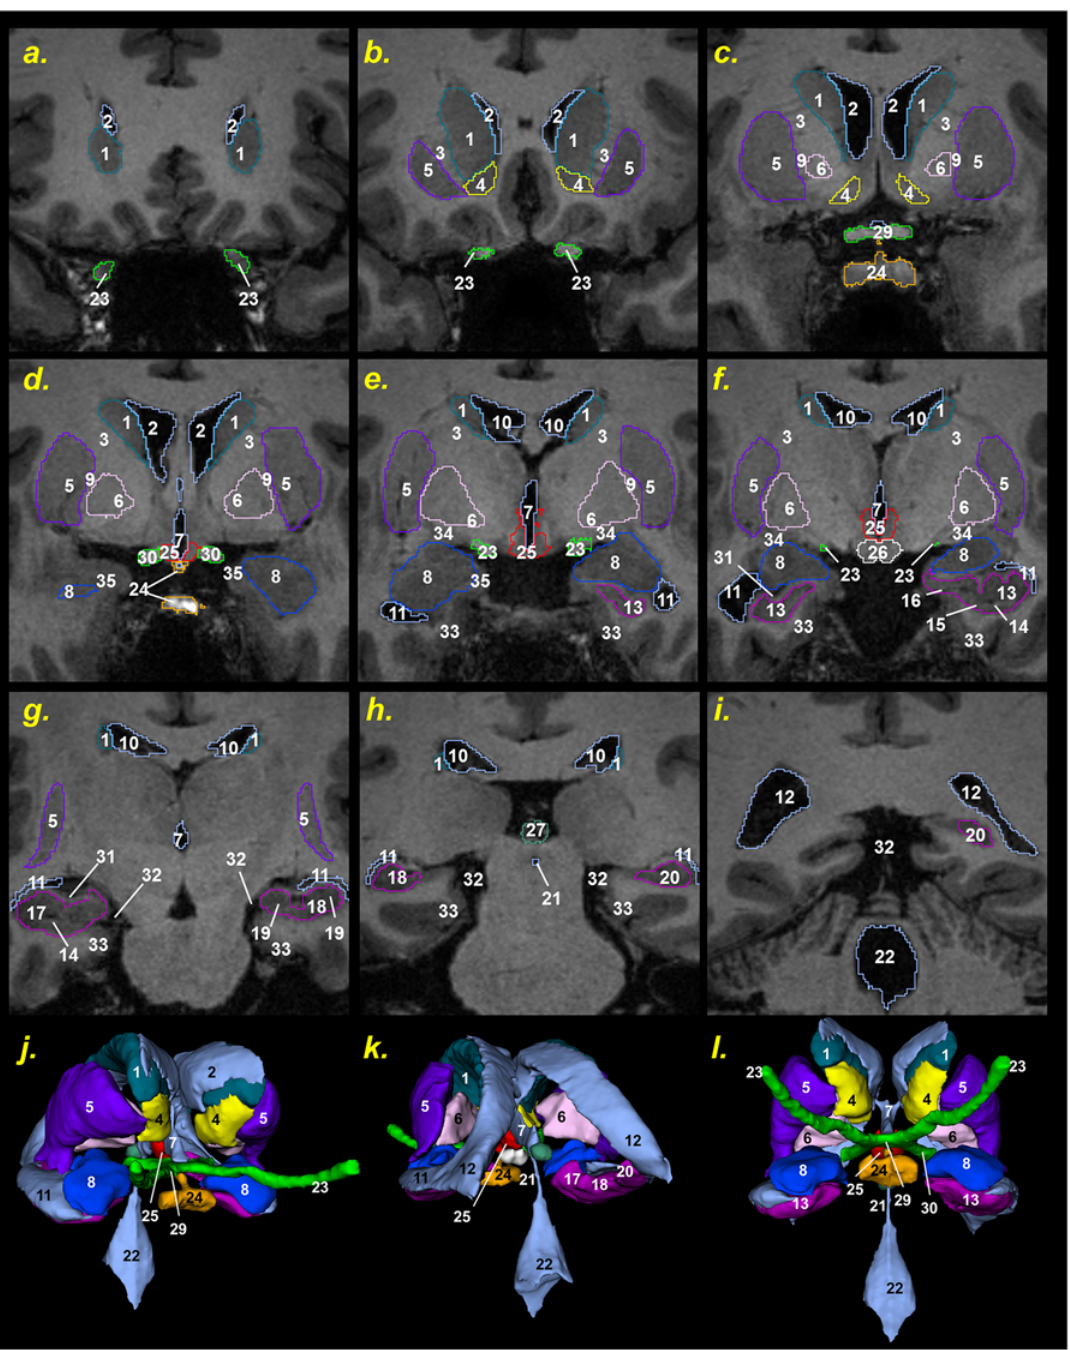
Fig 13. Segmentation of deep brain structures. Coronal slices of the deep brain structures from anterior to posterior (from a to i). Legend of the structures: 1 Caudate nucleus; 2 Lateral ventricles (anterior horn); 3 Internal capsule; 4 Nucleus accumbens; 5 Putamen; 6 Pallidum; 7 Third ventricle; 8 Amygdala; 9 External medullary lamina; 10 Lateral ventricles (body); 11 Lateral ventricles (inferior horn); 12 Lateral ventricles (collateral trigone); 13 Hippocampus (head); 14 Uncal sulcus; 15 Subiculum; 16 Uncinate gyrus; 17 Hippocampus (head) — gyrus dentatus; 18 Hippocampus (body) — gyrus dentatus; 19 Cornus ammonis; 20 Hippocampus (tail) — gyrus dentatus; 21 Cerebral aqueduct; 22 Fourth ventricle; 23 Optic nerve; 24 Pituitary gland and pituitary stalk or hypophysis and infundibulum; 25 Hypothalamus; 26 Mammillary body; 27 Pineal gland; 28 Anterior commissure; 29 Optic chiasm; 30 Optic tract; 31 Alveus; 32 Cisterna ambiens; 33 Parahippocampal gyrus; 34 Ansa peduncularis; 35 Entorhinal cortex. Right anterior oblique (j), left posterior oblique (k) and ventral caudal (l) view of the 3D reconstruction of the deep brain structures.